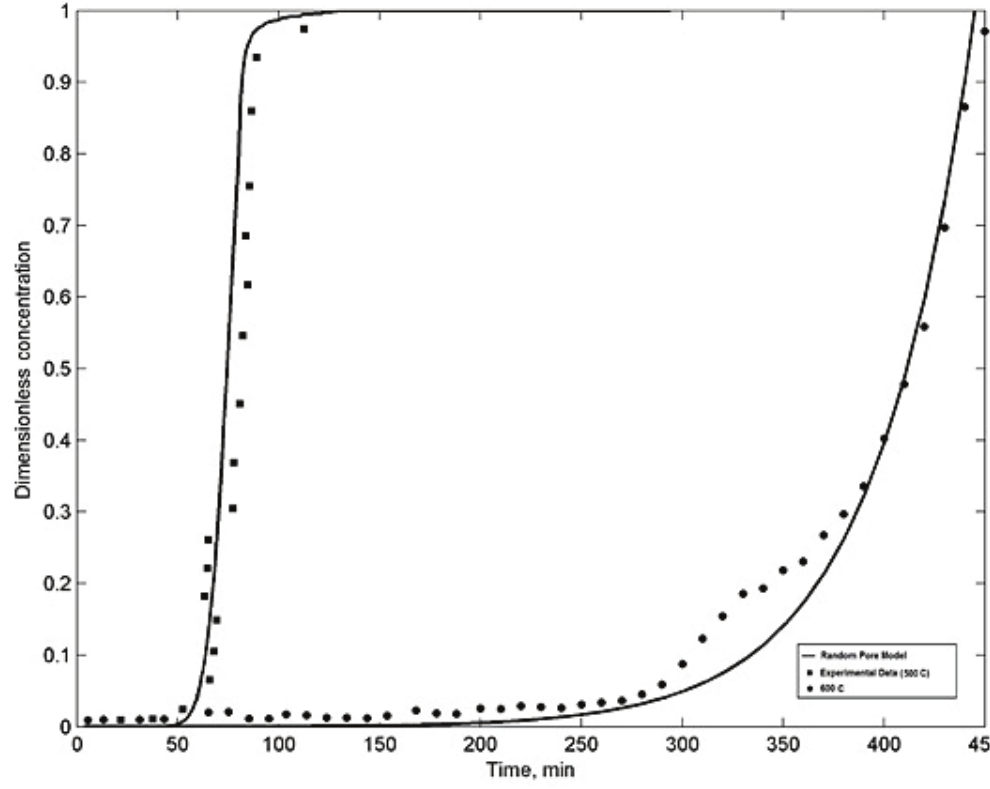
breakthrough curves from MgO packed bed reactor 2